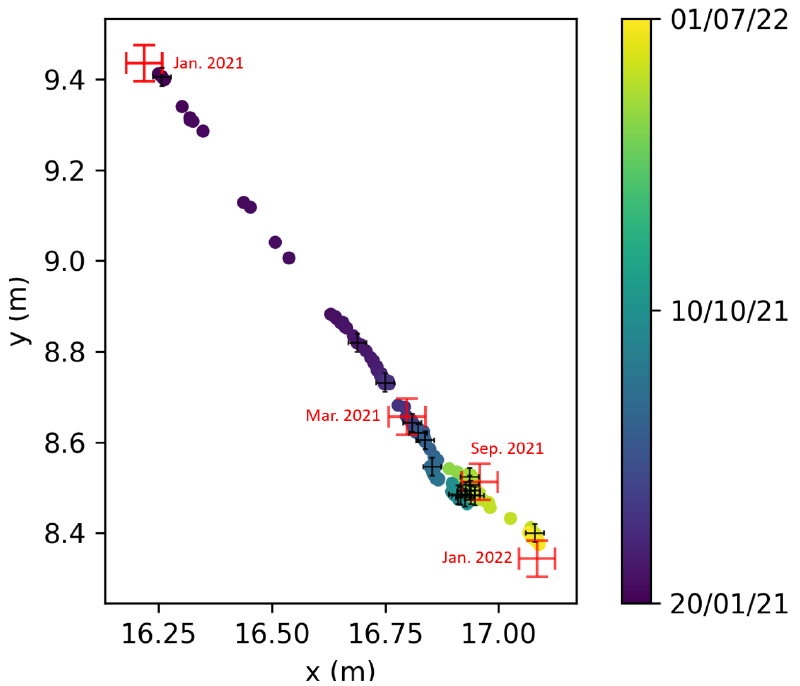
Figure 8. RFID localization in the xOy plane, using phase data for tag A (Figure 6). The total displacement is about 1.6 m. The color plot represents the time evolution of the RFID relative localization. The red crosses represent the reference measurements using a tacheometer, with an estimated error of about 4 cm. The tacheometer measurement of March 2021 is set as an absolute reference for relative localization. The black crosses correspond to the estimated random error bars for TD-phase localization (calculated via the model developed in Section